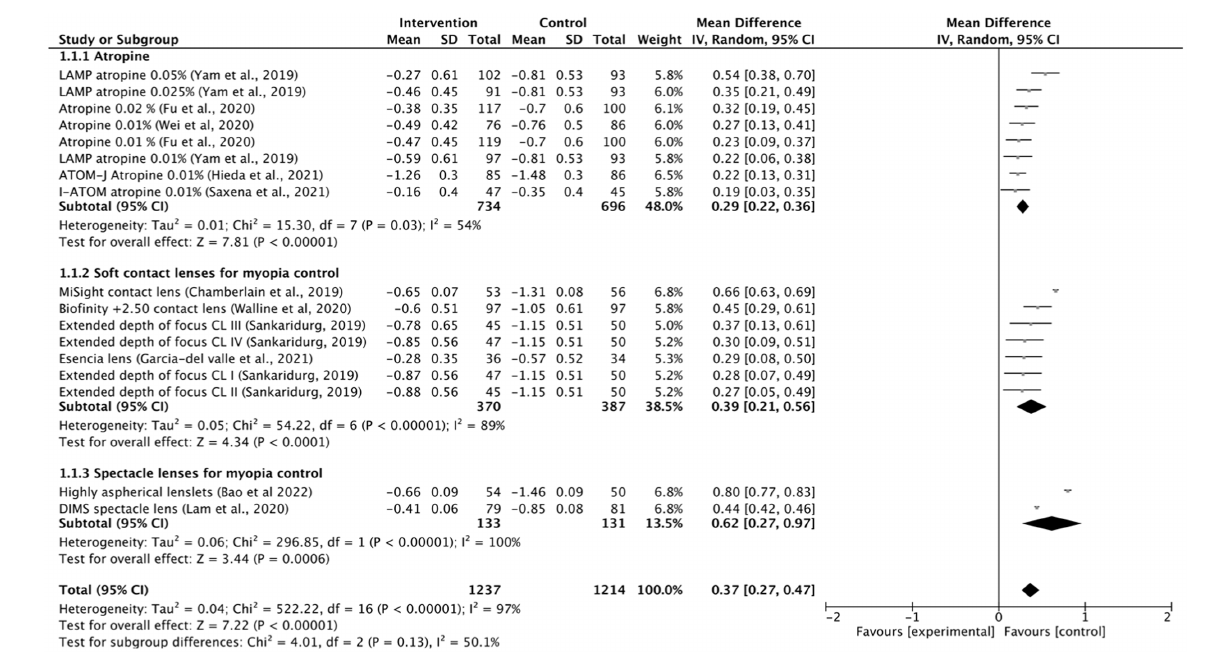
FIGURE 2 Forest plot of myopia progression (D) showing mean differences between treatment and control groups. The point estimate for the mean difference for each study is shown in gray color. The weight assigned to each study is represented by the size of each gray point estimate. The horizontal line through each gray point estimate shows the 95% confidence interval for the mean difference for each treatment. CL, contact lenses; CI, confidence interval; SD, standard deviation; K,